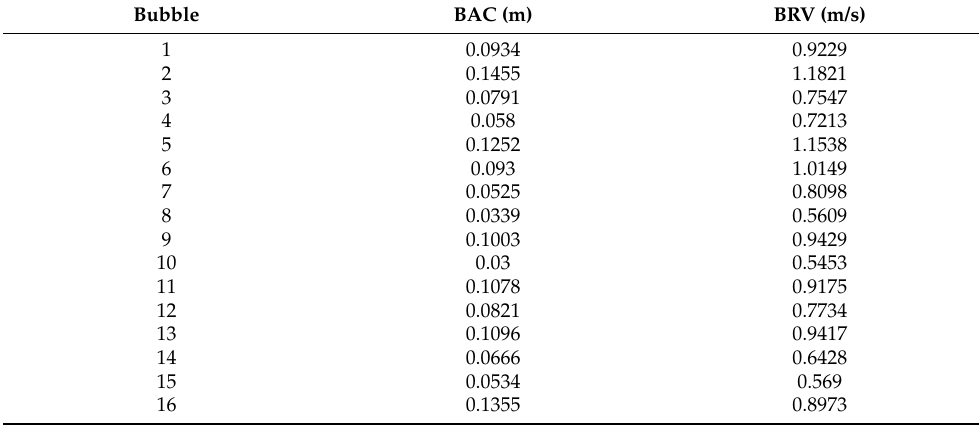
Table 6. Identification number for each bubble reported in Figure 15, along with size and velocity of each